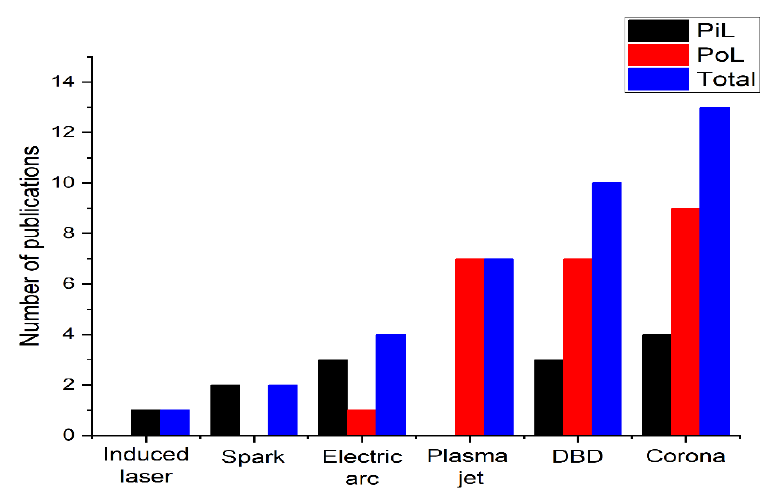
Figure 7. Plasma generation methods for saline-based water treatment, where PiL refers to the configuration in which the plasma is immersed in the liquid, and PoL to those configurations where the plasma is applied to the surface of the saline liquid.